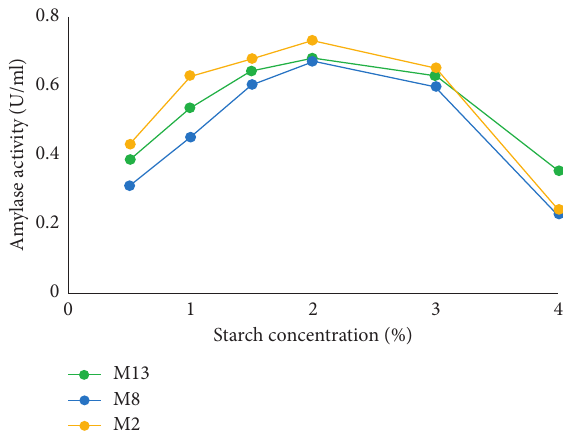
Figure 10: Effect of starch concentration on amylase activity.